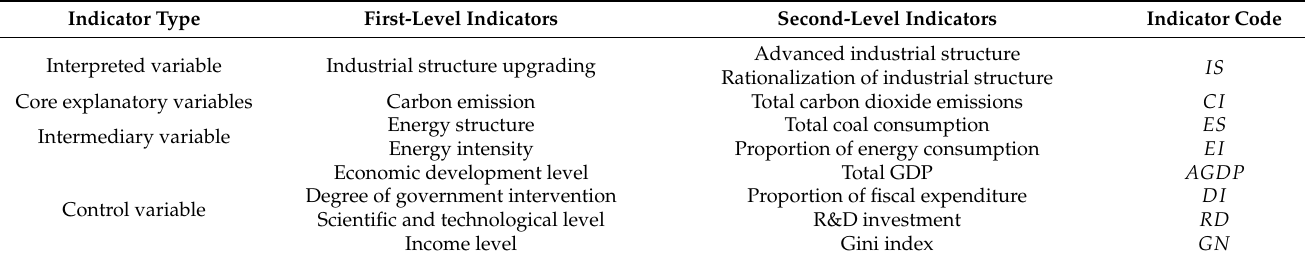
Table 1. Indicator